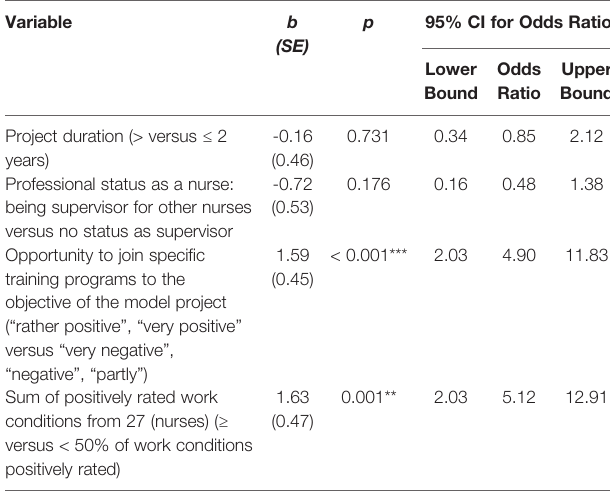
TABLE 5 | Full binary logistic regression for evaluations (EV) of nurses and selected independent variables ( N =